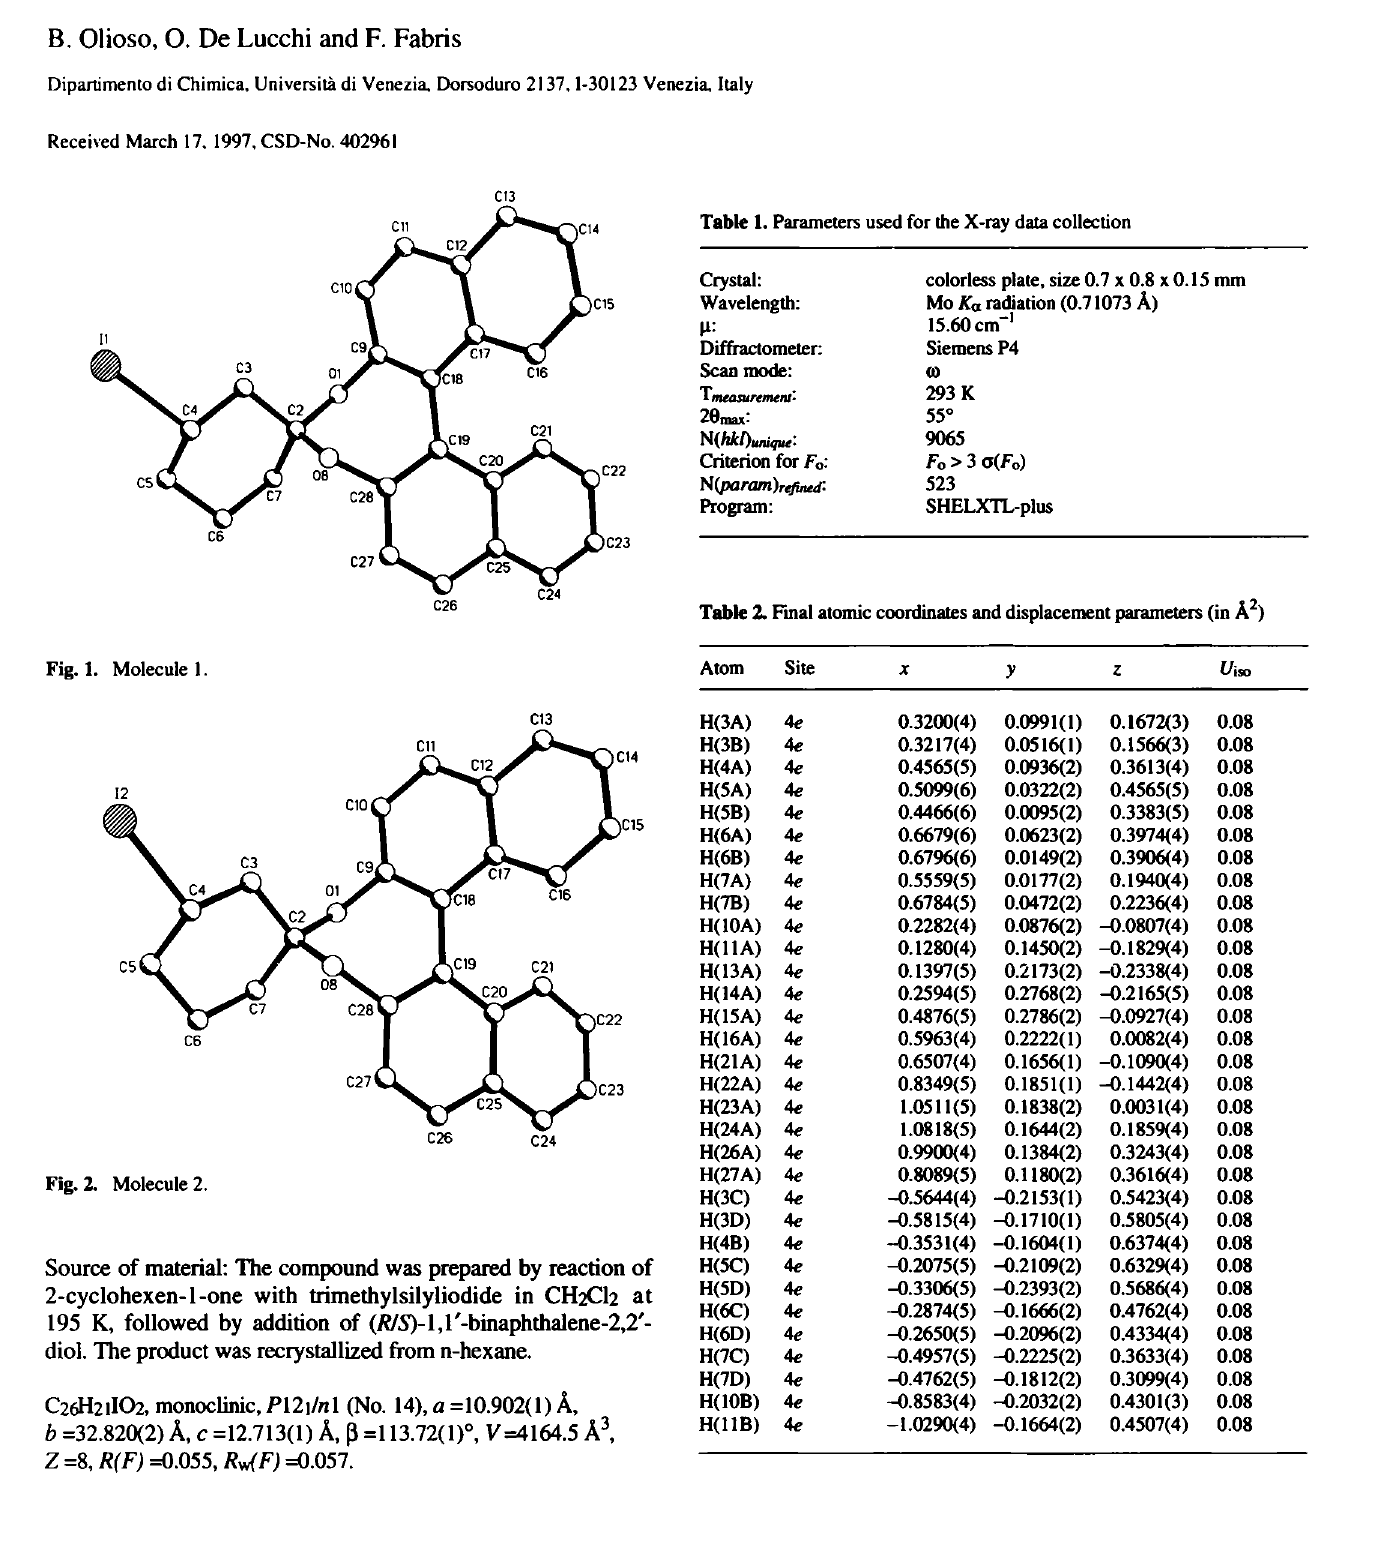
Table 1. Parameters used for the X-ray data collection